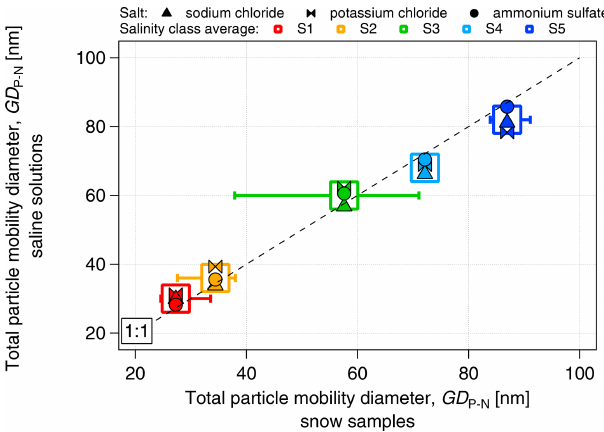
Figure 5. Comparison of the diameter of aerosolized particles pro- duced from inorganic salt solutions (sodium chloride, potassium chloride and ammonium sulfate) and snow samples as a function of salinity. The diameter is expressed as the geometric mean di- ameter calculated from the number size distribution of aerosolized